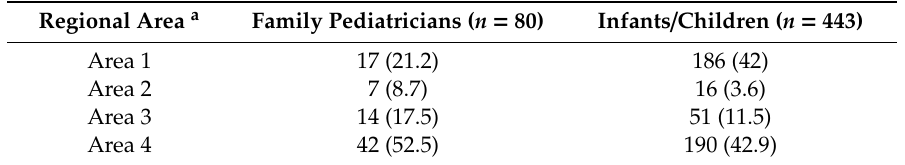
Table 1. Distribution of participating family pediatricians ( n = 80) and children ( n = 443) by regional area.